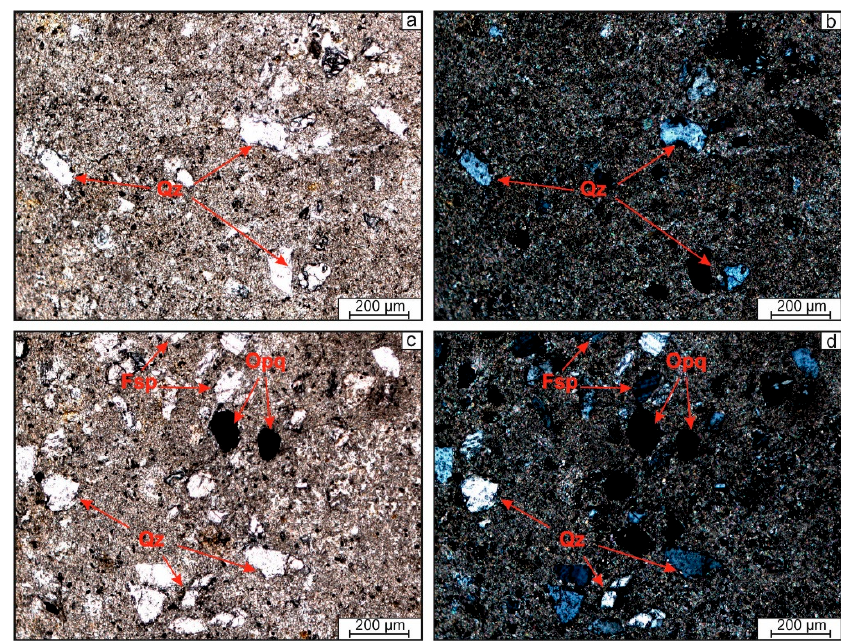
Figure 4. Thin-section photomicrographs in plane- and cross-polarized light of cold-seep carbonate nodules (sample AMK-6045/2): ( a , b ) typical carbonate matrix; ( c , d ) detrital grains of quartz, feldspars, and opaque minerals are interspersed within carbonate matrix. Qz—quartz, Fsp—feldspar, Opq— opaque minerals.